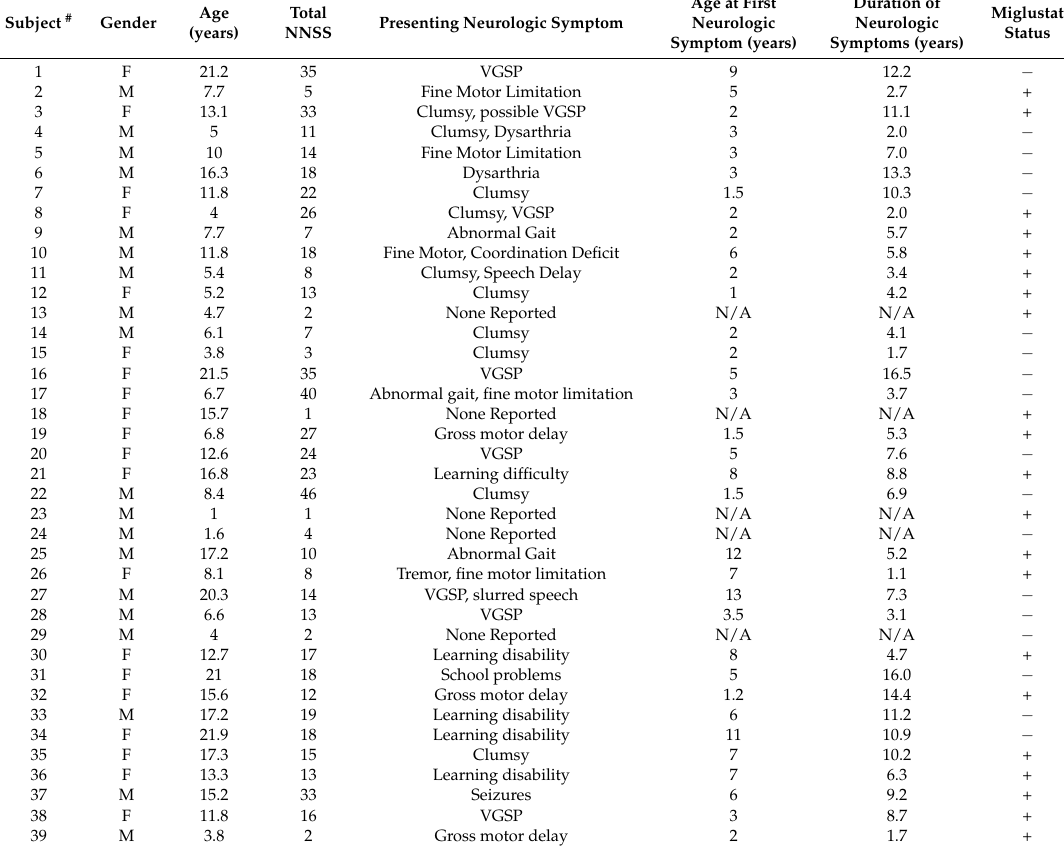
Table 3. Demographic, Severity Score, and Symptom Data for NPC Patients ( n =